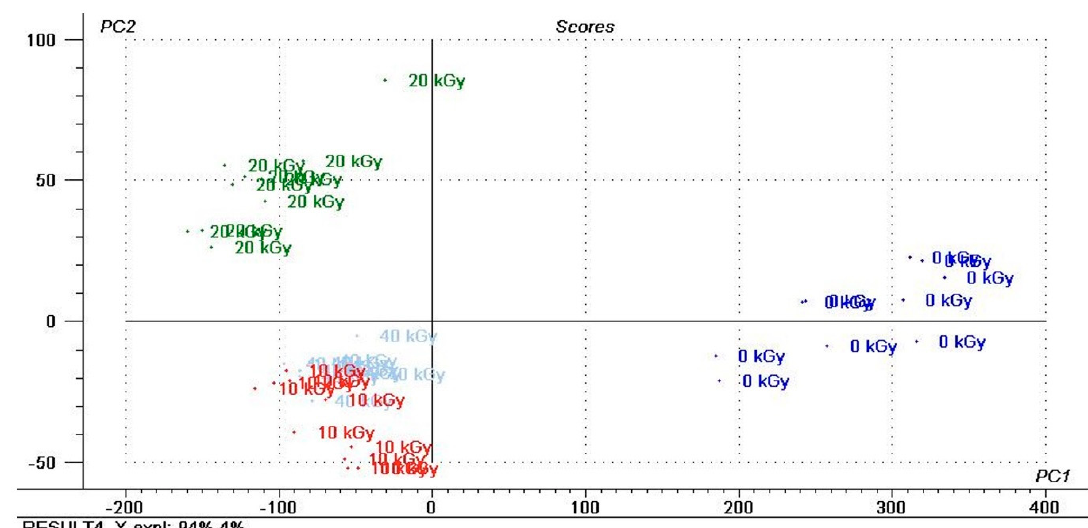
Figure 6. PCA results of IR spectra of the AA-CH-S film and the score plot for two significant principal components, PC1 vs. PC2 (non-irradiated (0 kGy) and irradiated with different doses (10, 20 and 40 kGy)).